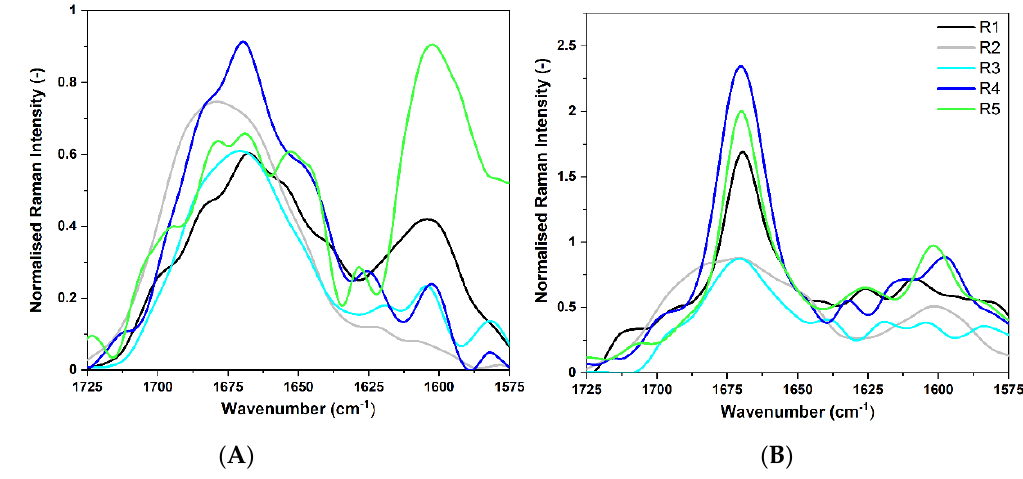
Figure 6. Normalized FT-Raman spectra of CsgA protein fragments, smoothed with SG 35 (see Methods), in the wavenumber range of 1725–1575 cm − 1 (Amide I). ( A ) Spectra for E. coli fragments after 30 days of incubation at 37 ◦ C, ( B ) Spectra for S. enterica fragments after 30 days of incubation at 37 ◦ C. Peptide concentration was 500 µ